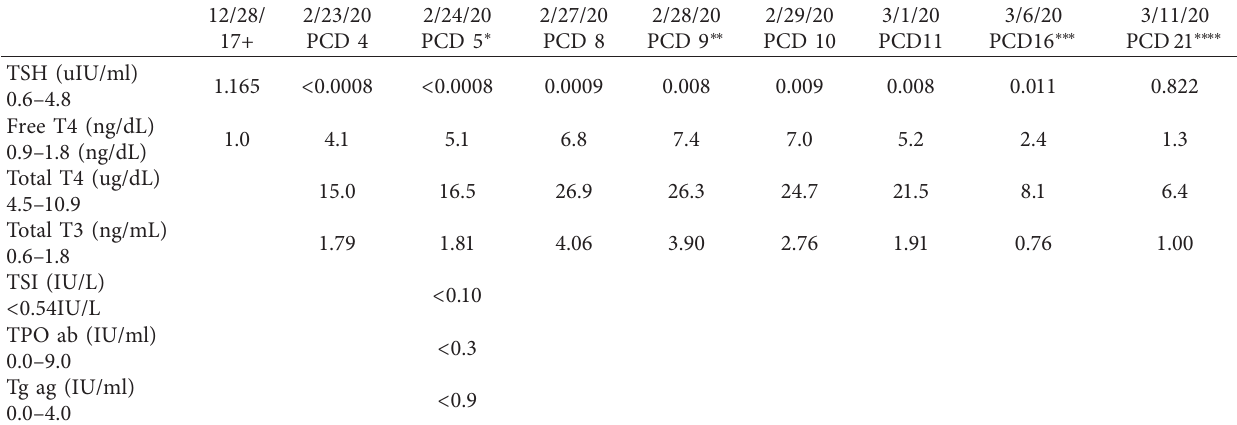
Table 1: Thyroid function tests.